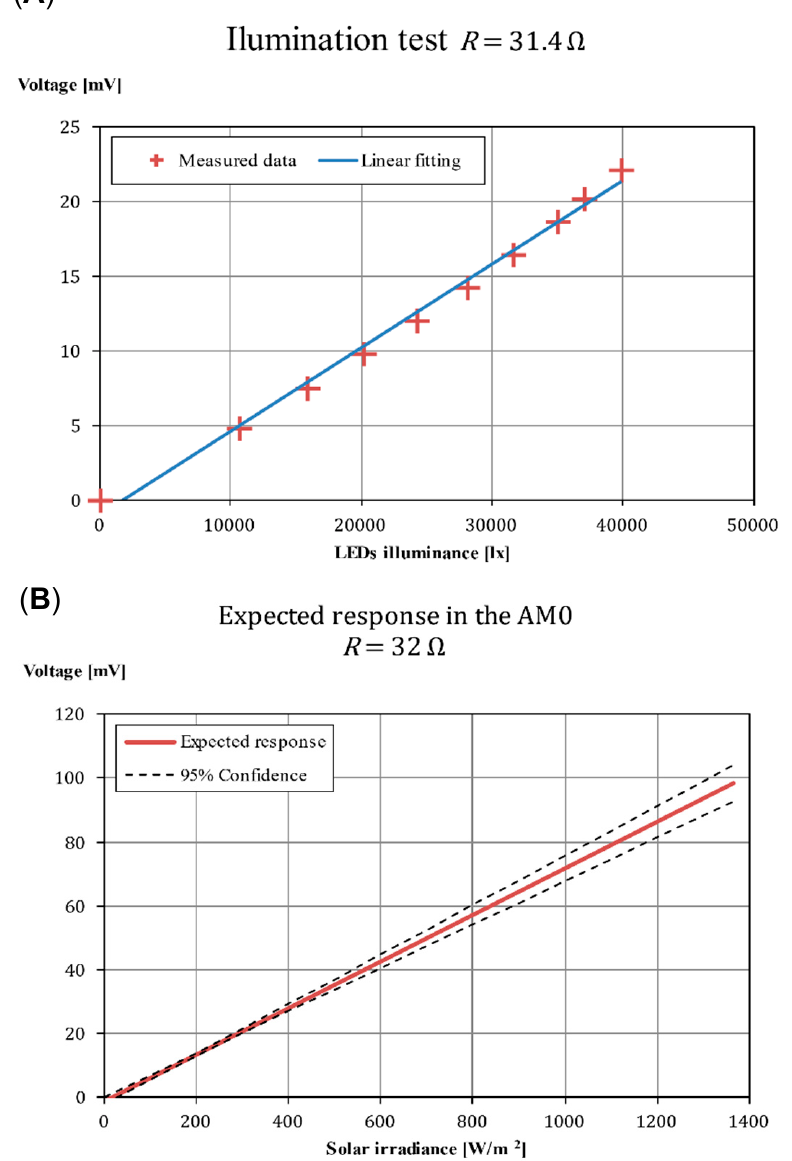
Figure 11. ( A ) Fitting of the SS1-X+ sensor. ( B ) Expected response of SS1-X+ sensor to AM0 spectrum irradiance. Table 3. Coefficients of the slope, m , and offset, n , obtained from the linear fittings to the expected response of the SS1-X+ photodiode under LED and AM0 irradiance (see also Figure 11).